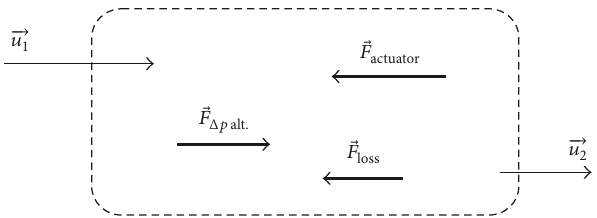
Figure 3: A hydraulic machine in the most generic case: the fluid momentum is altered by the combined action of forces ⃗𝐹 ⃗𝐹 . Δ𝑝 alt . , and loss